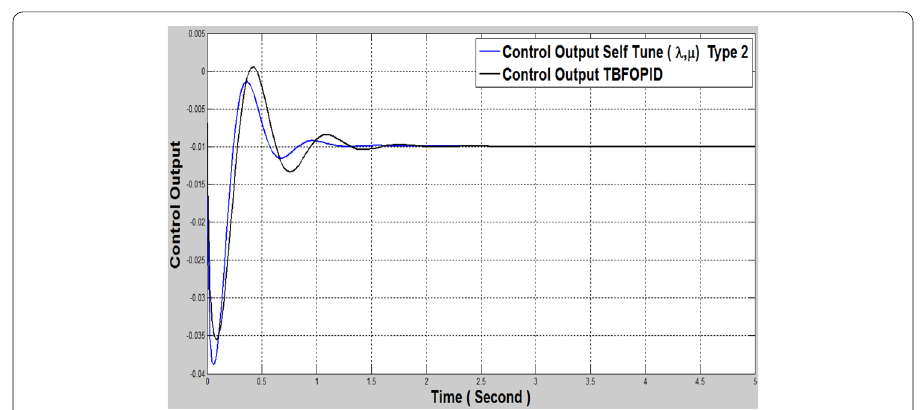
Fig. 23 Controller output via IT2FST ( λ and μ